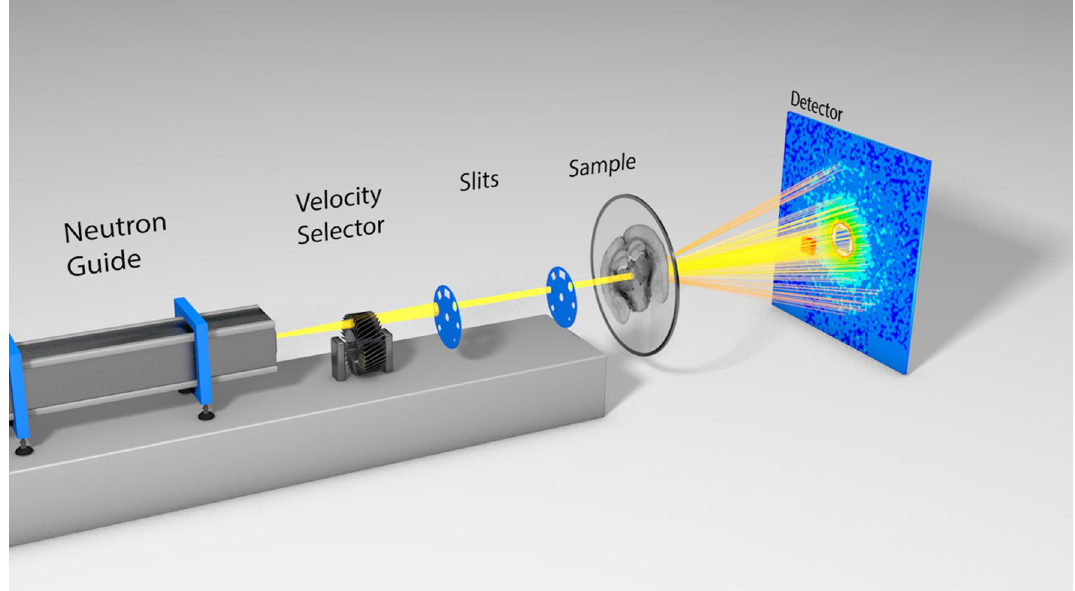
Figure 7. Scheme of the scanning SANS geometry to study the mouse brain section. During measurement, the transversal orientation of the brain section had a counter-clockwise offset of 35° with respect to the horizontal alignment of the laboratory